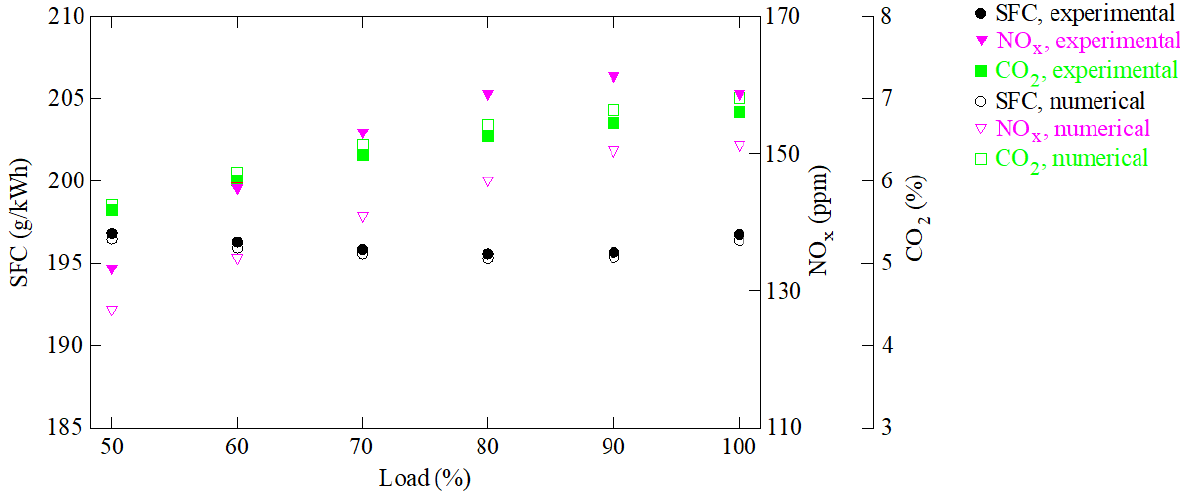
Figure 5. Consumption and emissions of CO 2 and NO x experimentally and numerically measured. Operation under diesel combustion without ammonia.